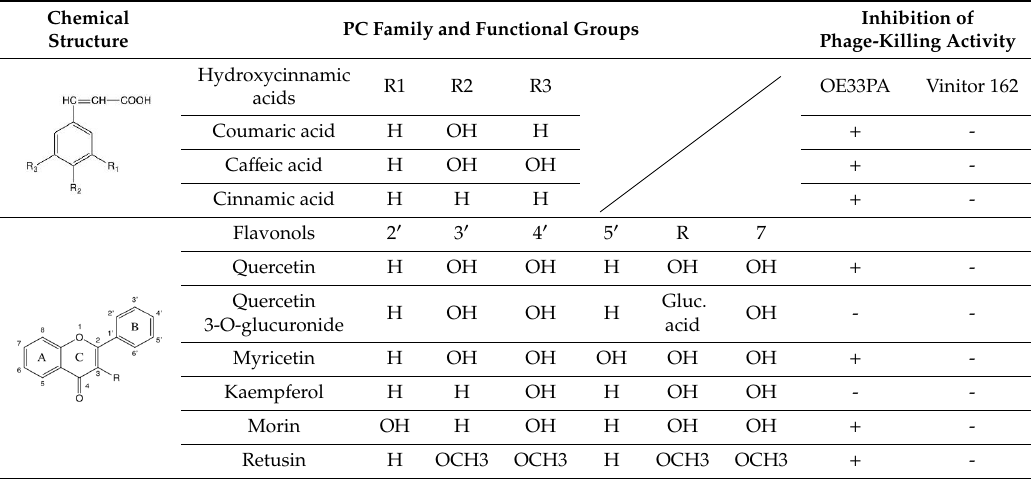
Table 1. Name and chemical structures of the hydroxycinnamic acids and flavonoids tested in killing assays with the lytic oenophages OE33PA and Vinitor.